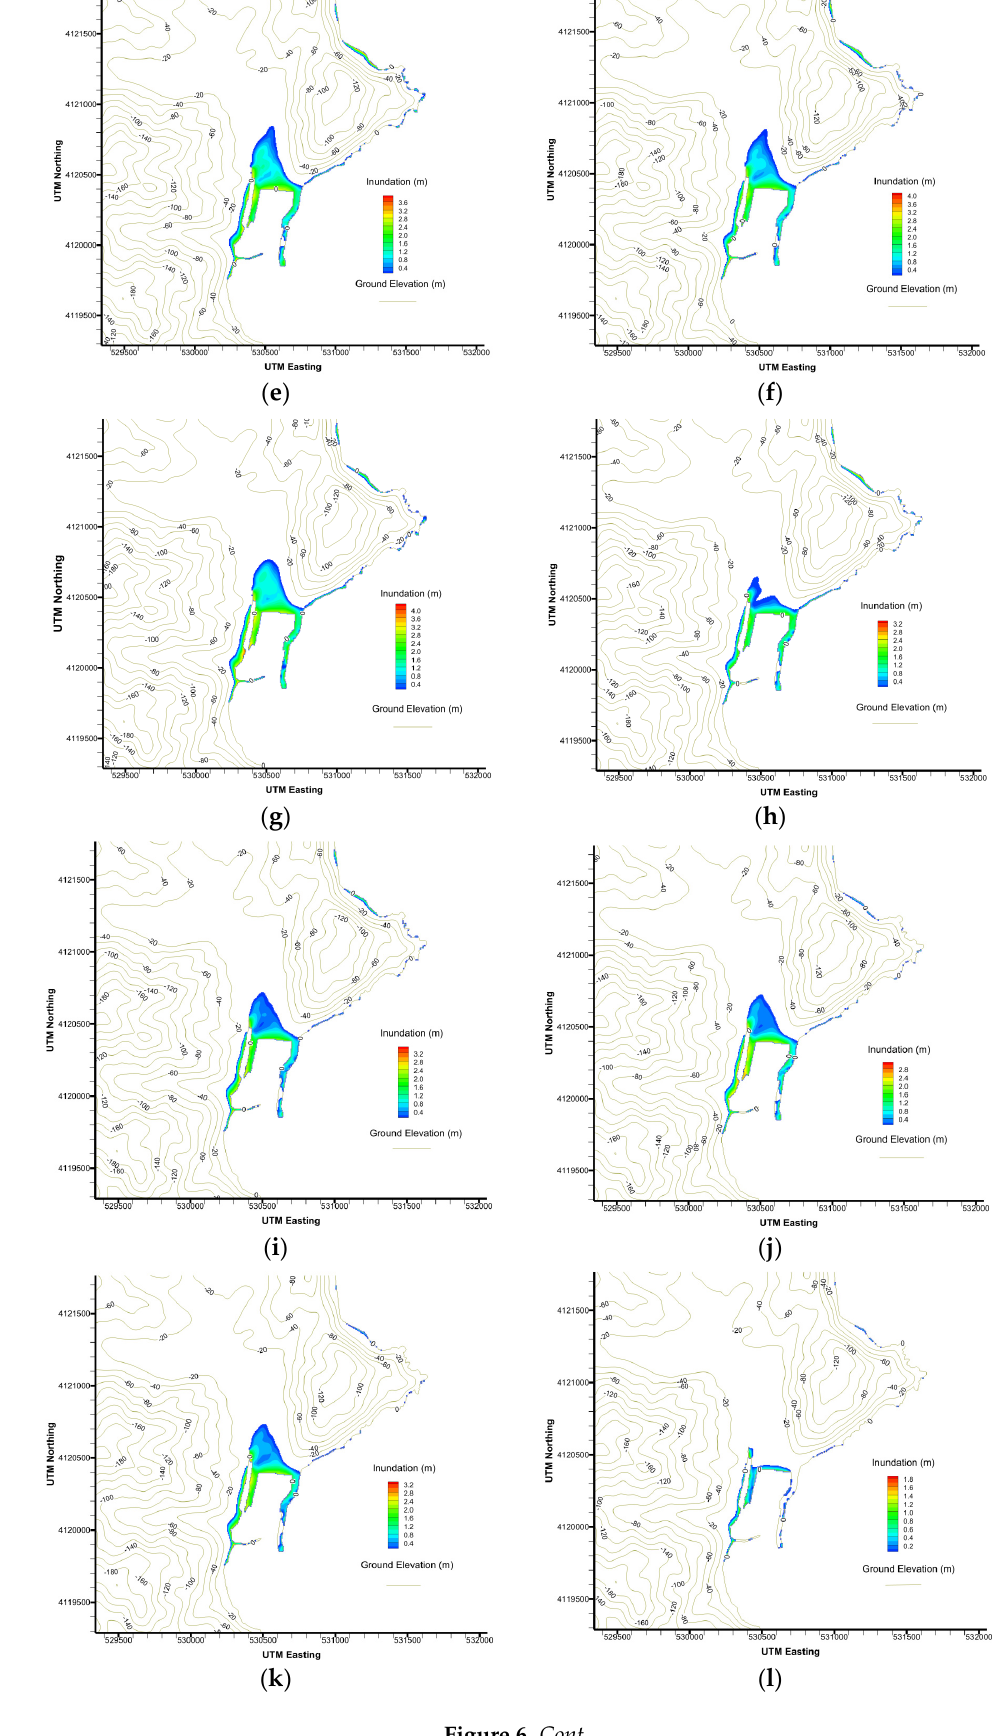
Figure 6. Cont. Figure 6.